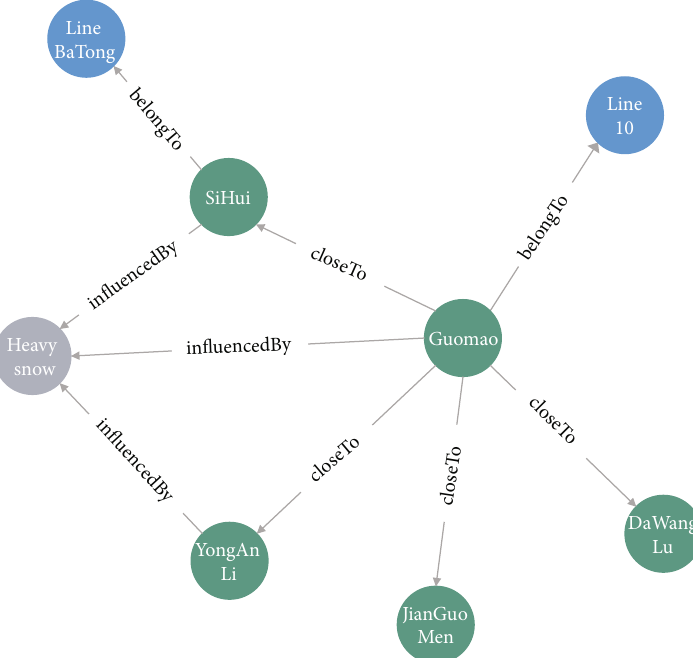
Figure 3: Metro tra ffi c knowledge graph stored in graph database.